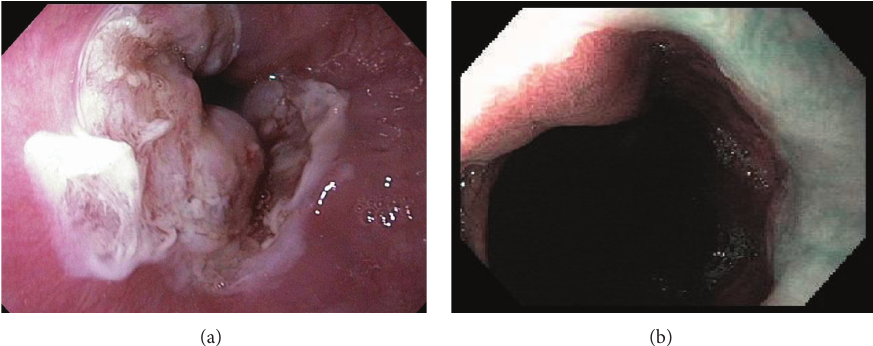
Figure 2: (a) Scar was found in the area of previous mucosal resection. Ablation of Barrett’s mucosa was performed with multipolar electrocoagulationwithsuccess.(b)Atongueofcolumnarappearingmucosawasfoundintheesophagusspanning1 cm:noresidualcolumnar appearing mucosa.